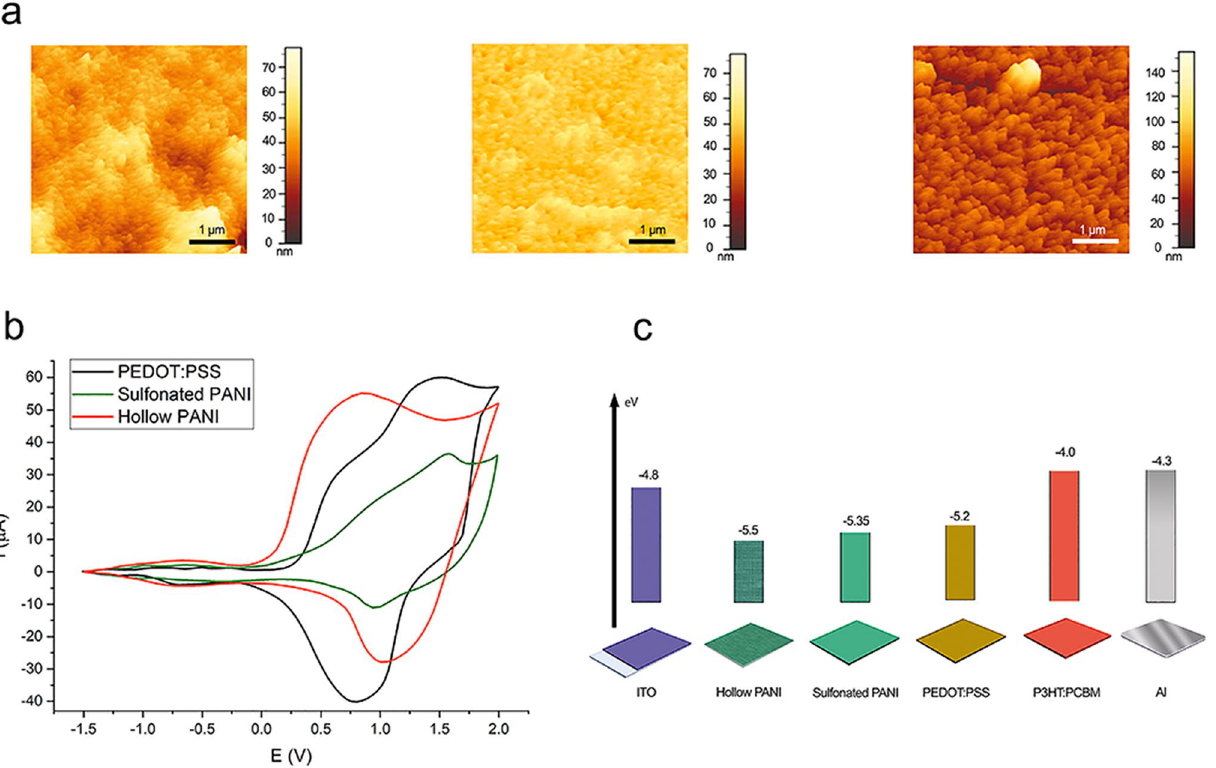
Figure 4. Structural and electrochemical properties of the developed organic solar cell. ( a ) AFM topographical maps of the buffer layer surface structure made of sulfonated PANI, PEDOT:PSS, and hollow core PANI. The AFM image z-scales are 77 nm (PANI), 78 nm (PEDOT:PSS), and 154 nm (hollow core PANI). ( b ) Investigation by cyclic voltammetry of sulfonated PANI, PEDOT:PSS, and hollow core PANI to estimate the optical properties of buffer layers, and ( c ) schematic of the energy levels for all the layers used in solar cells. E ox (eV) HOMO (eV) E red (eV) LUMO (eV) E g (eV) PEDOT:PSS